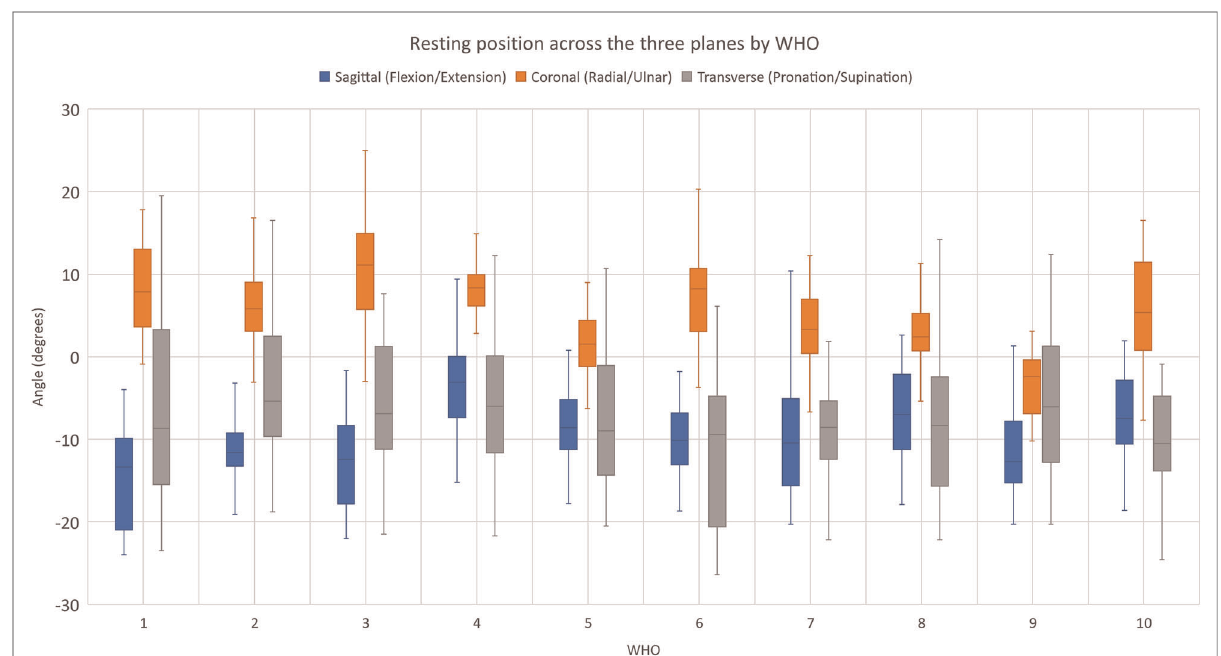
FIGURE 2 Resting position across the three planes by WHOs across ADLs. For the coronal plane, statistical signi fi cance is denoted by+and ++ when the mean value was statistically greater than 0, indicating that the wrist was at radial deviation with p <0.05 and p <0.001, respectively. For the sagittal plane, statistical signi fi cance is denoted by * and ** when the resting value was statistically different from the prescribed 10° – 15° of extension for p <0.05 and p <0.001. The red dotted lines show the prescribed resting positions in the sagittal plane (10° and 15° of extension).